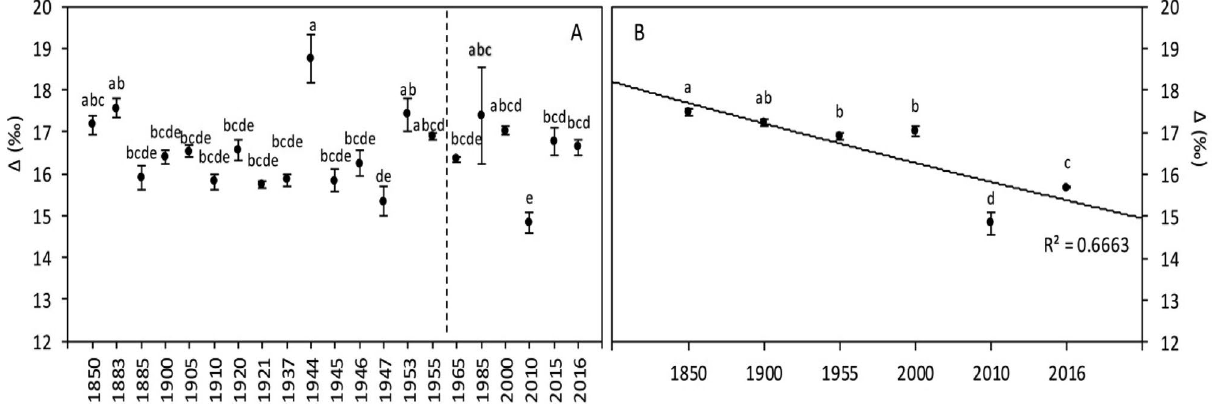
Figure 2. Wheat grain carbon isotope discrimination (Δ 13 C) of global ( A ) and Broadbalk experiment ( B ) samples. The dashed line corresponds to the separation between the [1850–1955] and [1965–2016] periods, based on the increase of [CO 2 ]. Data are means ± standard errors (n = 3–14). The same letters indicate no statistically significant differences among years (Fisher’s LSD, p ≥ 0.05).